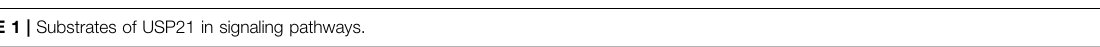
TABLE 1 | Substrates of USP21 in signaling pathways.